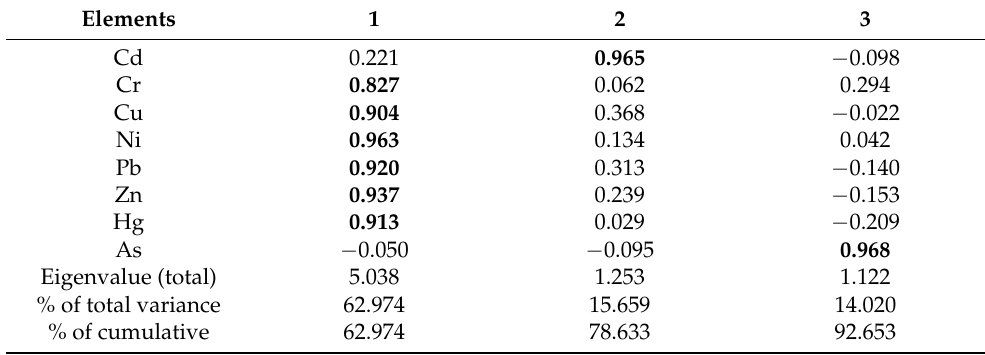
Table 8. Rotated component matrix of factor